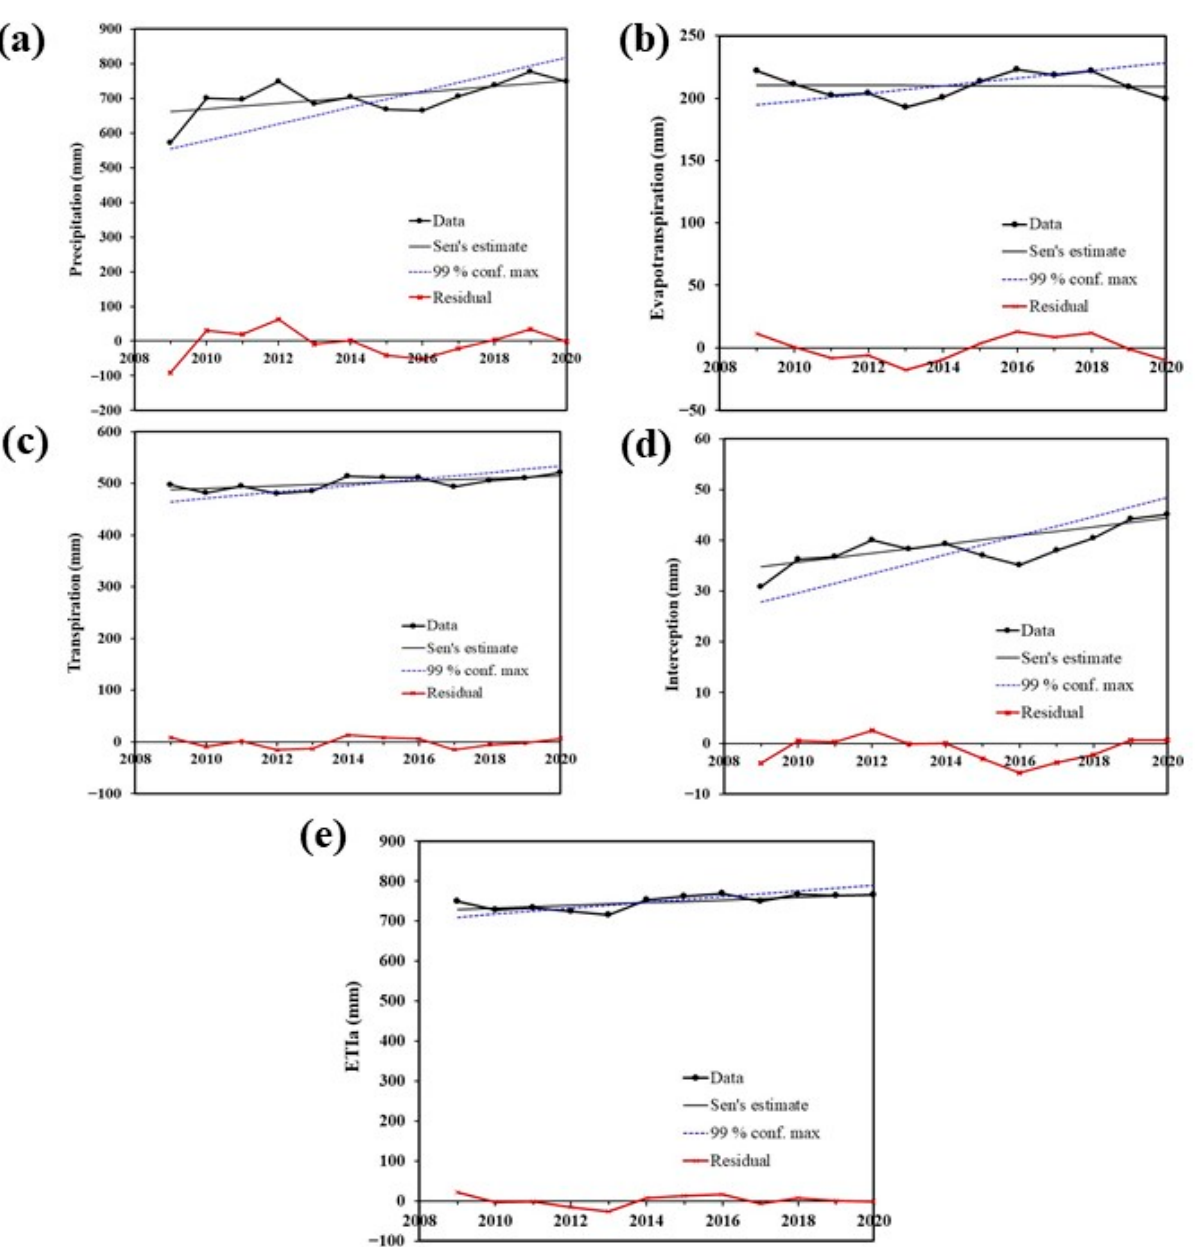
Figure 5. Interannual variability in ( a ) precipitation, ( b ) evapotranspiration, ( c ) transpiration, ( d ) interception, and ( e ) ETIa from 2009 to 2020 across the NRB.